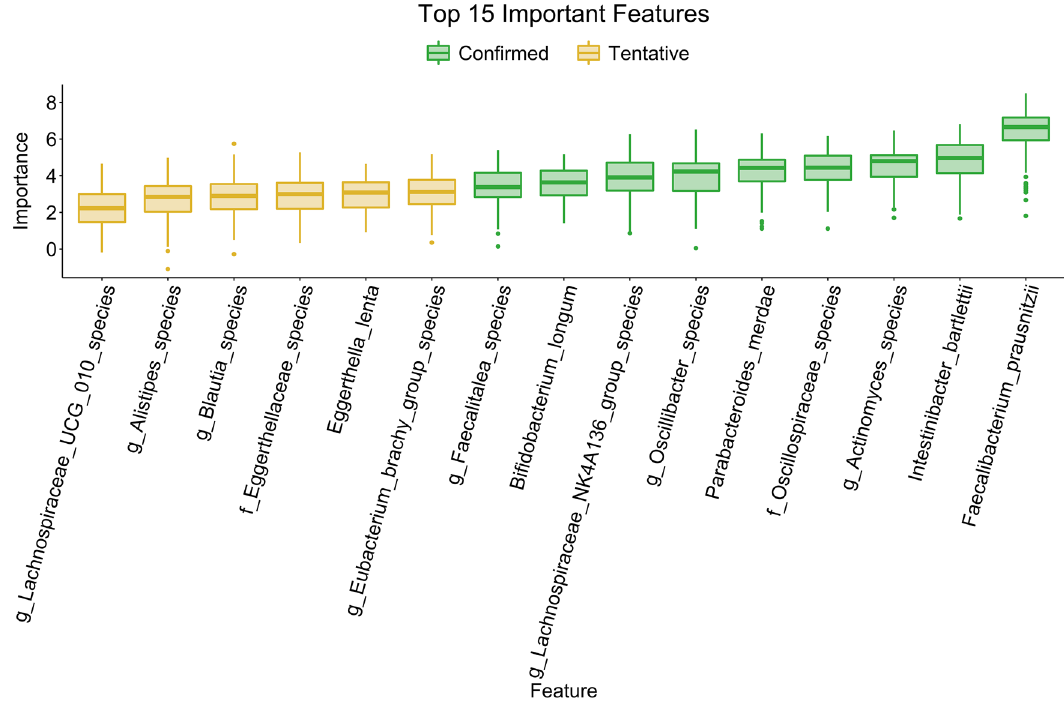
Figure 6. Random Forest identifies key species in differentiating between the microbiome of patients with breast cancer and healthy controls. The random forest machine learning algorithm was utilized to see if the fecal microbiome could differentiate between BC and HC. We utilized a bootstrapped random forest algorithm of 500 trees. Significance was based on the Boruta algorithm with a significance level of 0.01 highlighted in green.